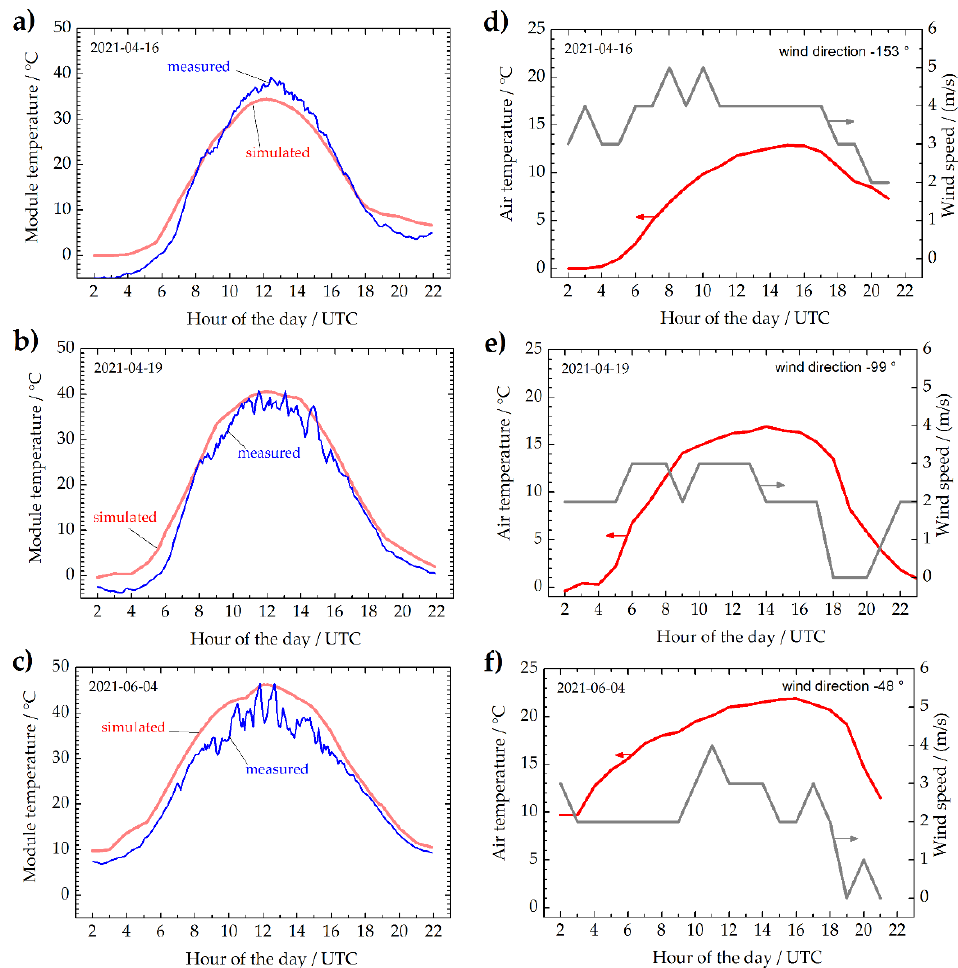
Figure 2. Left column ( a–c ): Simulated and measured module temperatures on three different days (date in the upper left corner). Right column ( d–f ): Air temperature, wind speed, and average wind direction angle relative to the azimuth of the PV modules between 9 h and 15 h UTC on corresponding